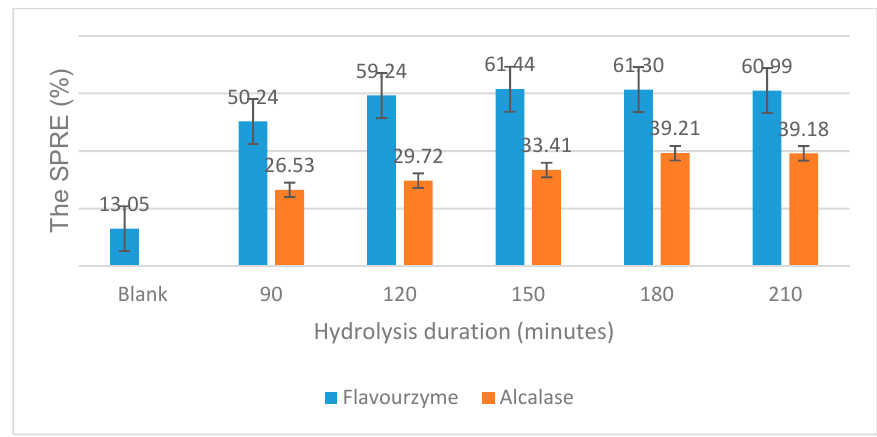
Figure 12. The effect of hydrolysis duration on the SPRE. Figure 12. The e ff ect of hydrolysis duration on the